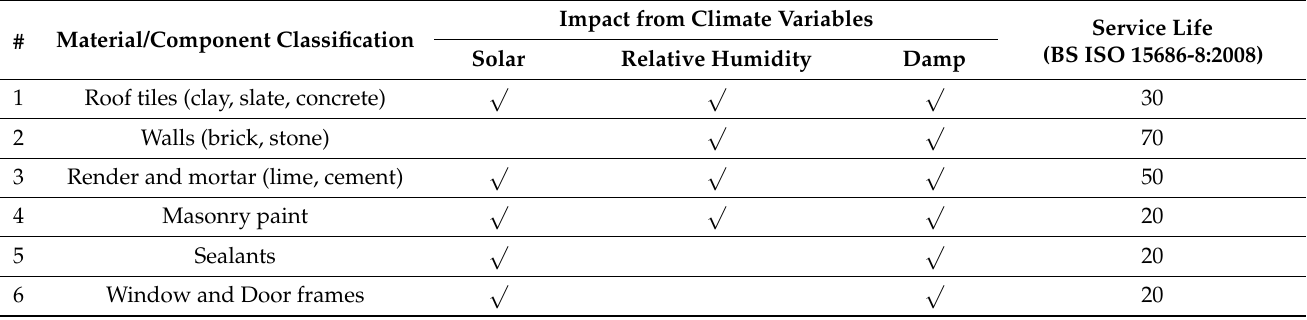
Table 1. Building fabric components included in the building-fabric analysis along with the climate variables that impact each component’s